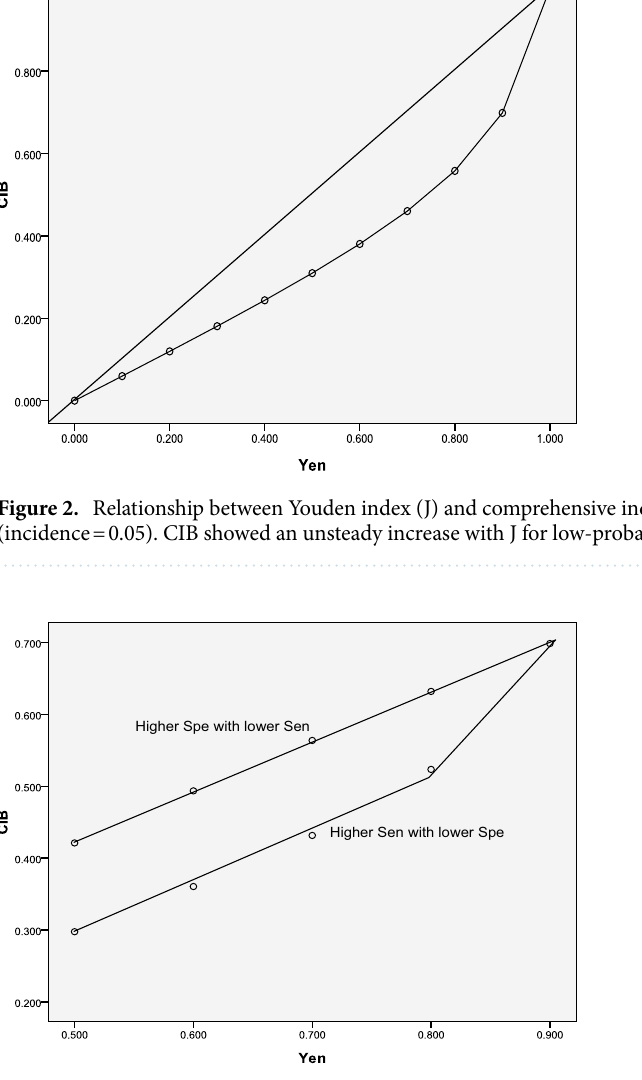
Higher Sen with lower Spe